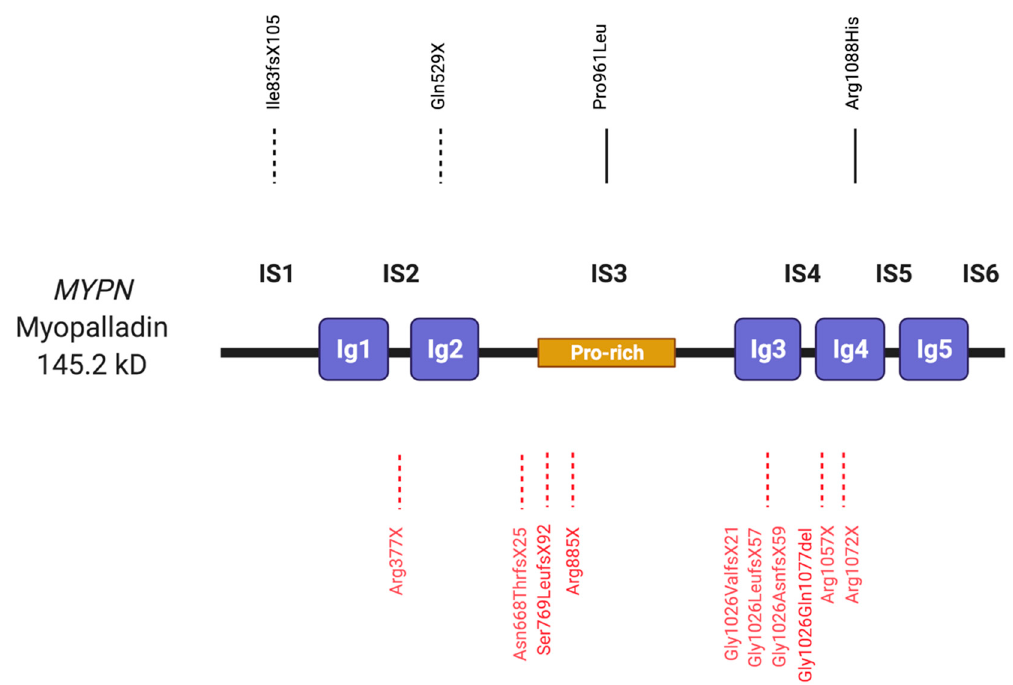
Figure 3. Schematic representation of Myopalladin shown as a monomer with variants in the MYPN gene that have been previously reported in individuals with myopathy (red) or cardiomyopathy (black). Solid lines represent missense variants and dashed lines are truncations. Ig—immuno-globulin like domain, IS—interdomain insertion, Pro-rich—Proline-rich. Created with BioRender.com (access on 07/03/3021).